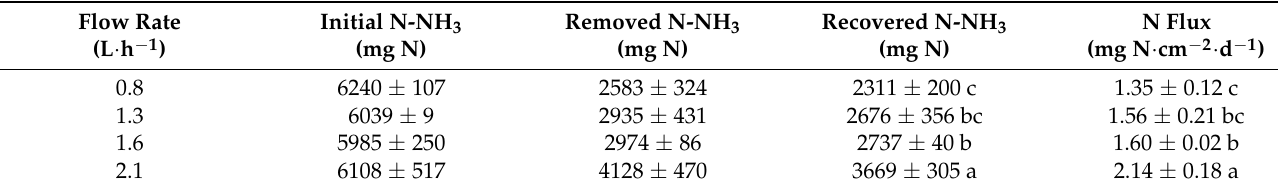
Table 2. Initial NH 3 mass in the synthetic solution (Initial N-NH 3 ), NH 3 mass removed from the liquid (Removed N-NH 3 ), NH 3 mass recovered in the acidic solution (Recovered N-NH 3 ) and N flux as a function of the acid flow rate. Flow Rate (L · h − 1